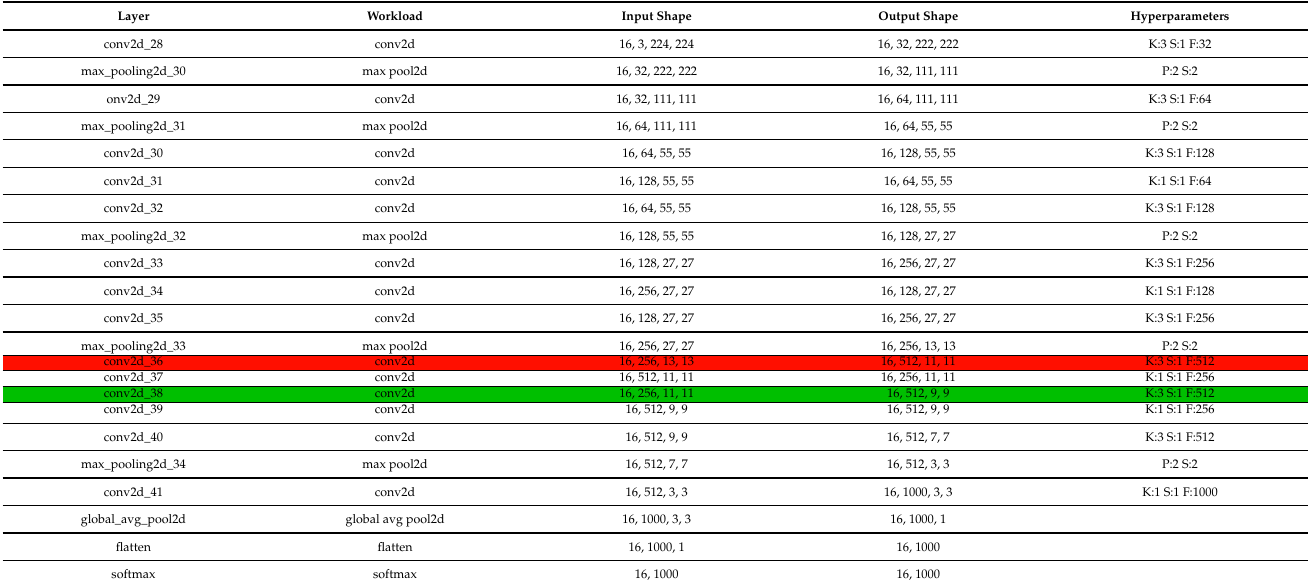
Table 4. Overview of the layer configurations of the test network. The layer configuration of the convolutional layer with the large underestimation of the inference latency is marked in red, the green row represents a similar layer which achieved a significantly shorter inference latency.